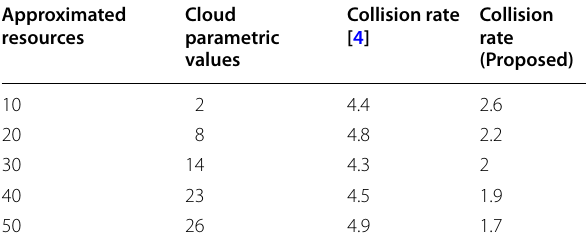
Table 2 Collision rate of multiple cloud data Approximated